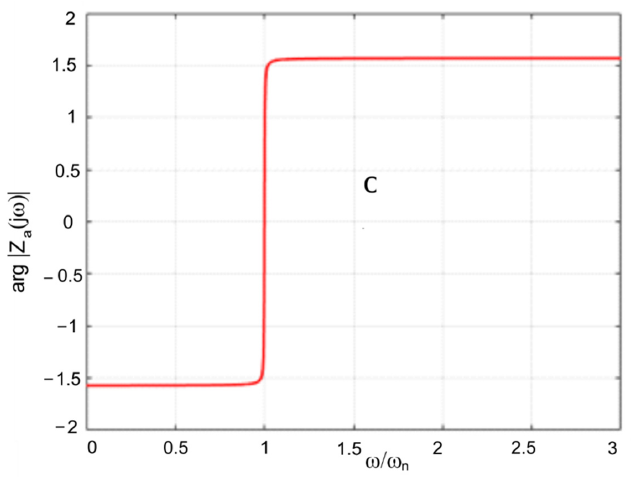
Figure 6. Characteristics of the HAC impedance phase.